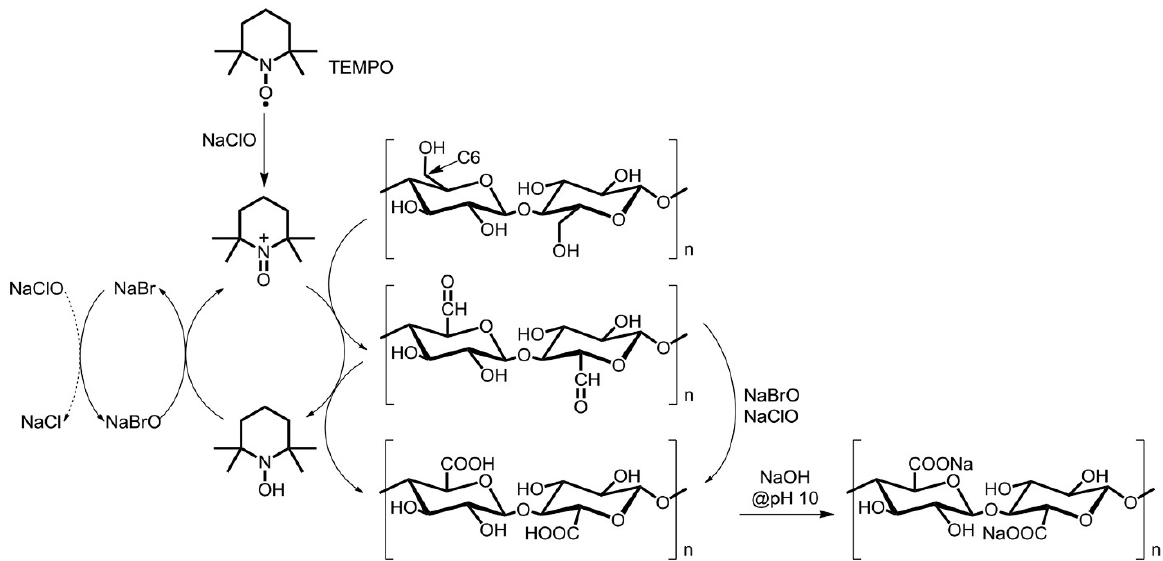
Scheme 1. Mechanism of selective oxidation of cellulose in the presence of TEMPO and sodium hypochlorite (re-drawn after ref.